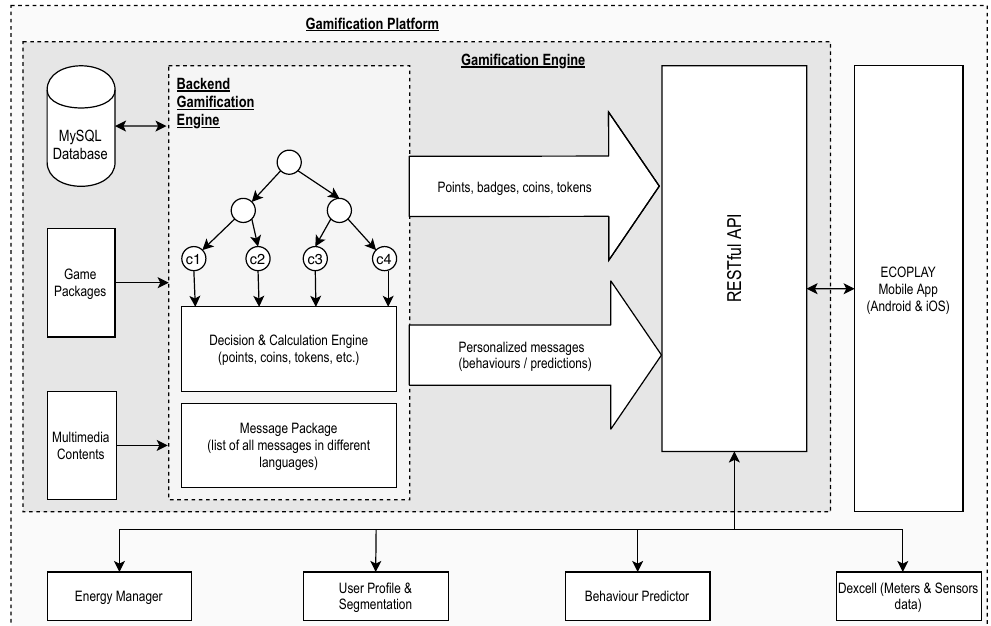
Figure 11. Gamification